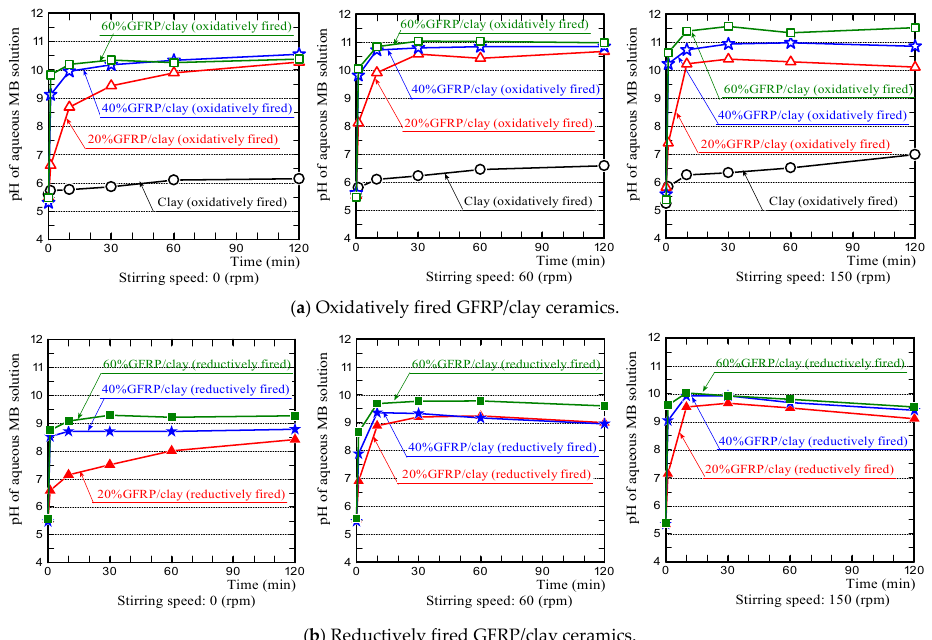
Figure 10. The temporal changes in pH for the MB aqueous solutions.